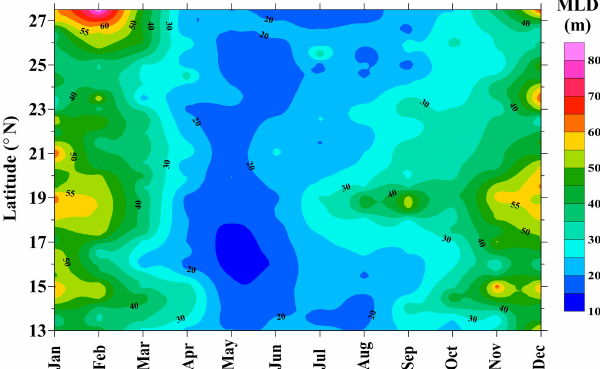
Figure 3. Hovmöller diagram of the MLD climatology along the axis of the Red